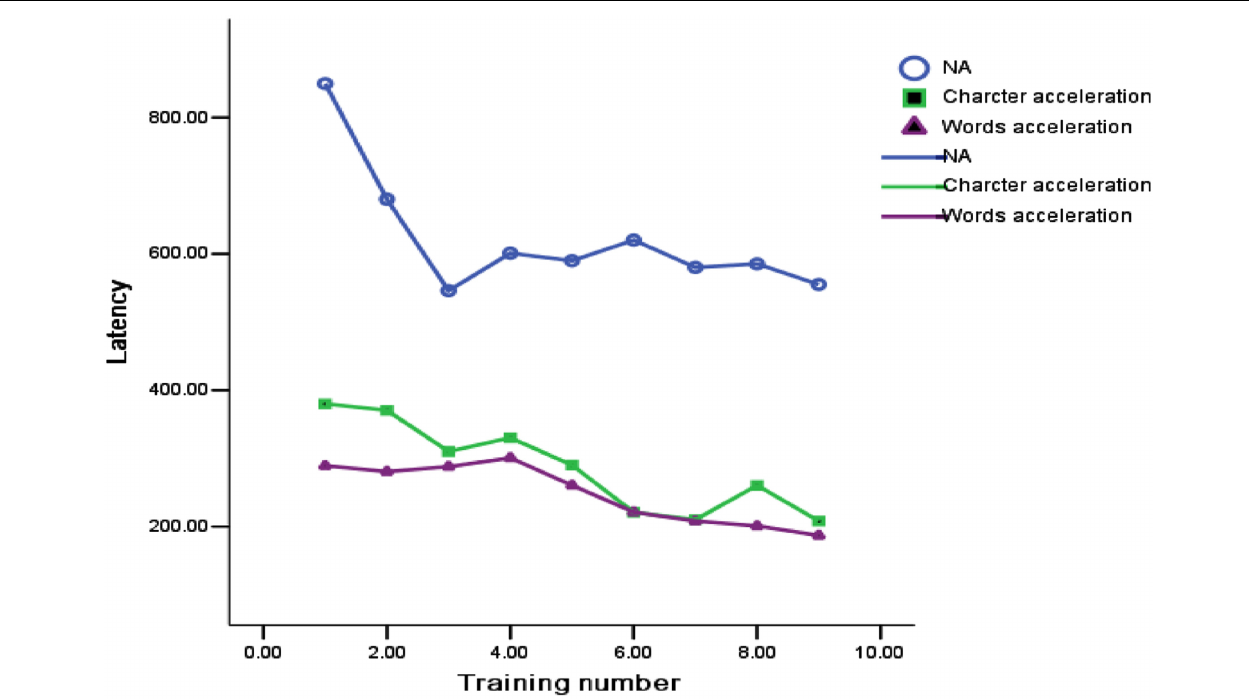
FIGURE 1 | The change of Chinese children with RD’s reading speed in the training process of three different accelerated reading groups.